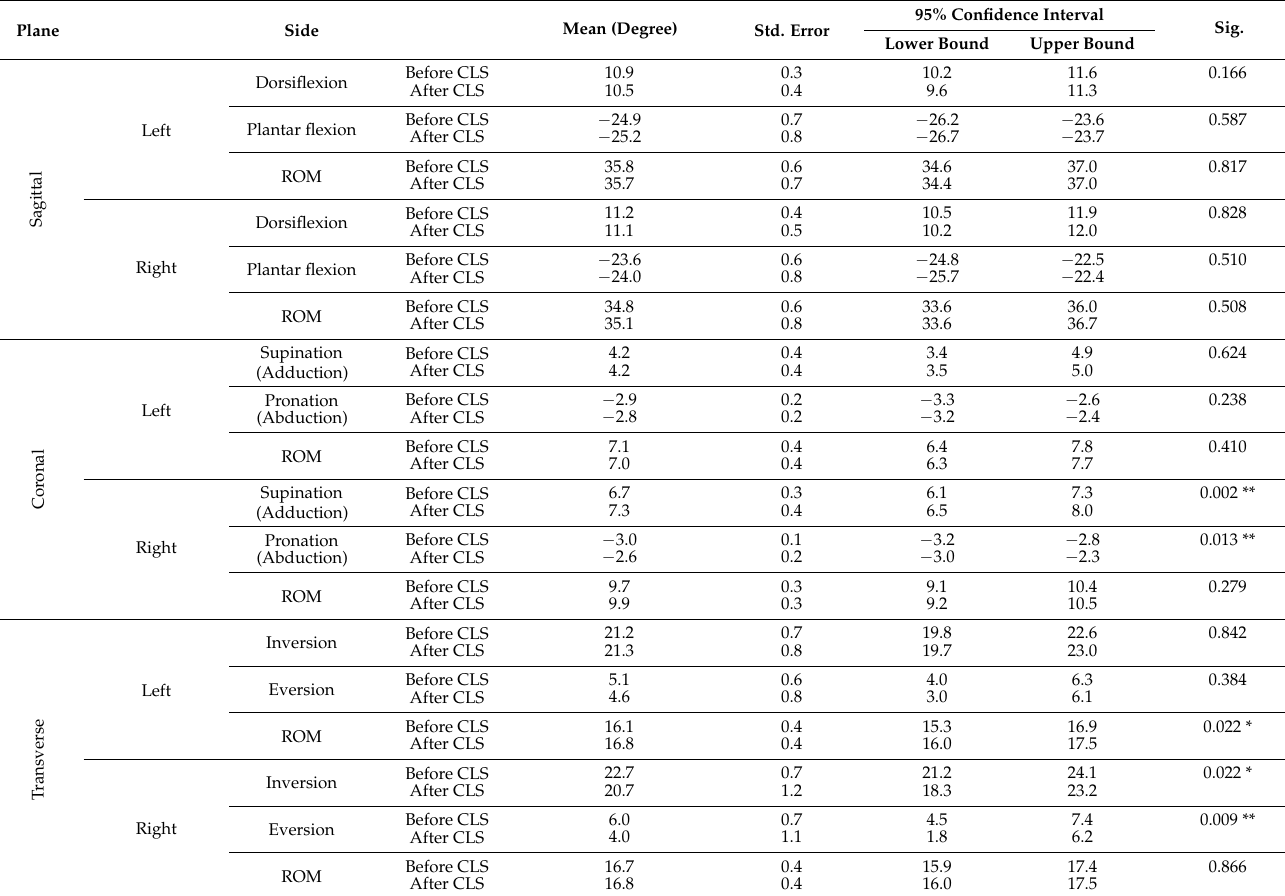
Table 5. Ankle Joint Angle in sagittal, coronal, and transverse planes.